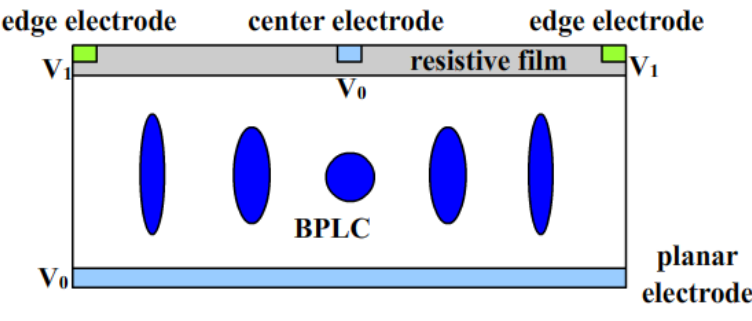
Figure 15. The cross section of PS-BPLC microlens using a resistive film